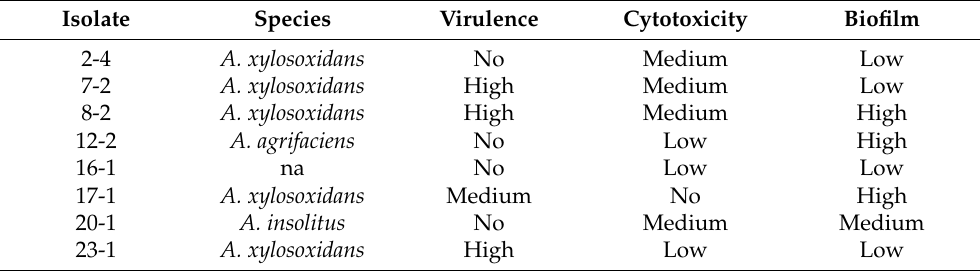
Table 1. Type of infection of the clinical isolates and levels of activity for each pathogenic characteristic. Isolate